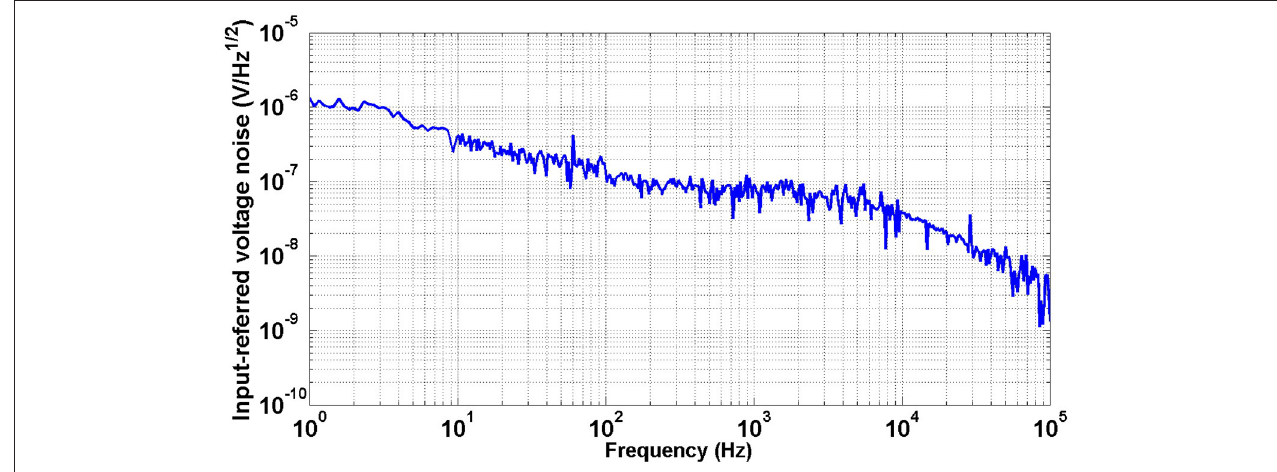
FIGURE 19 | Measured input-referred noise voltage spectrum.